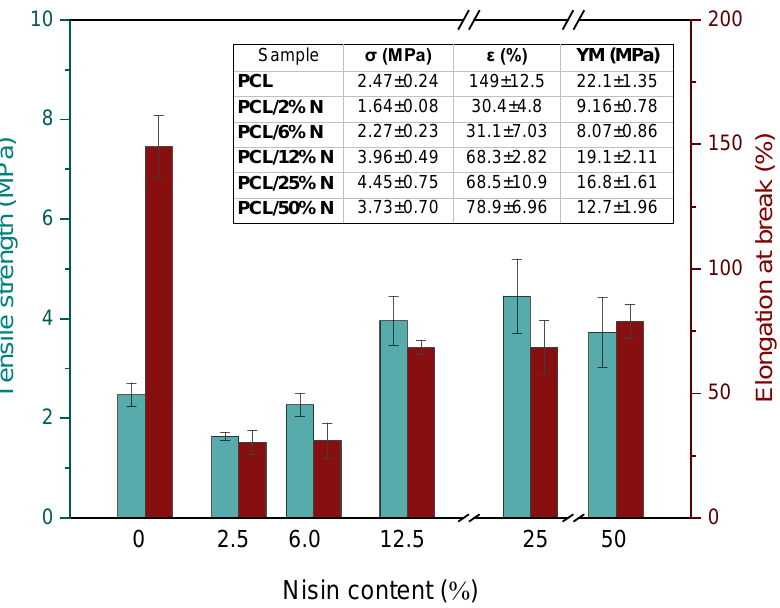
Figure 5. Changes in mechanical properties such as Young´s modulus (YM), tensile strength ( σ ) and elongation at break ( ε ) for PCL membrane strips with different nisin concentrations varied from 0 to 50%.